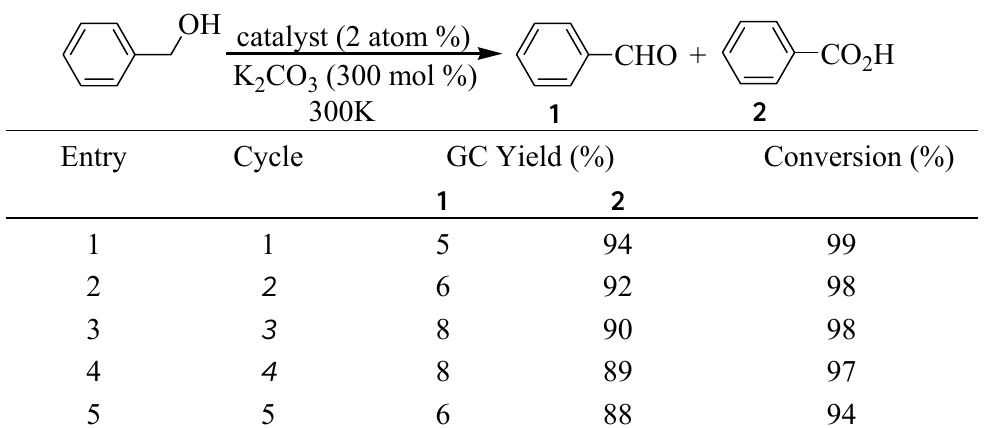
Table 2. Recoverability studies for the aerobic oxidation of benzyl alcohol by O :PVP/Au Fe 3 4